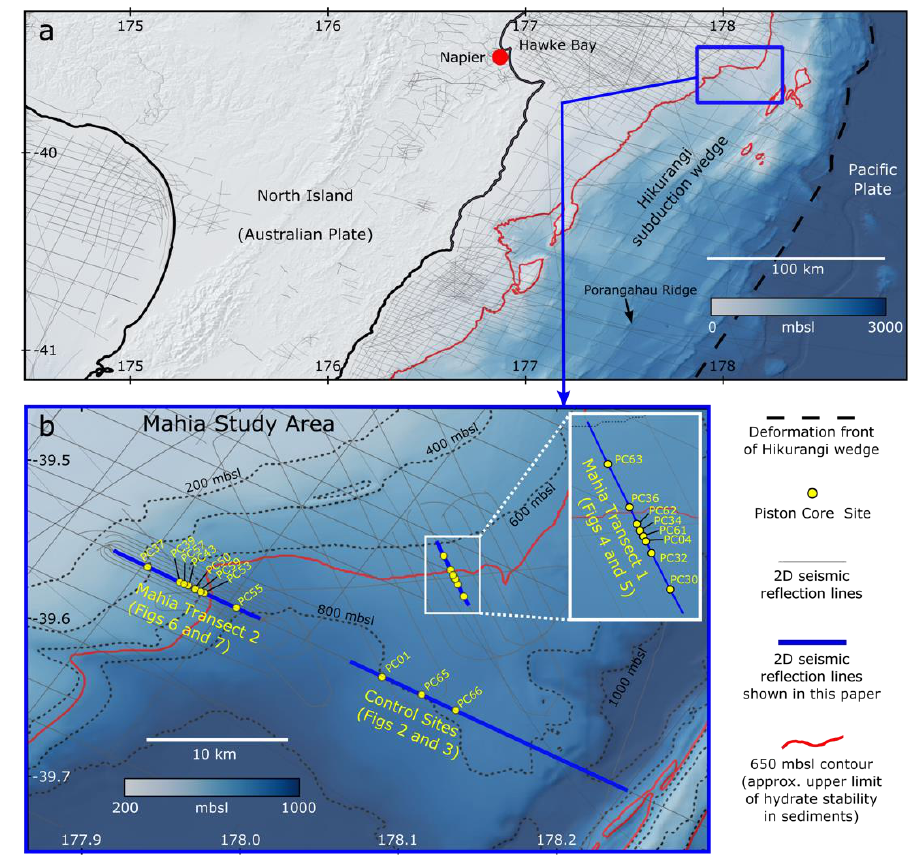
Figure 1. ( a ) Regional overview map showing the location of the study area (blue box) within the Hikurangi subduction wedge, east of New Zealand’s North Island. Map coordinates are in degrees (WGS84 datum). “mbsl” = meters below sea level. ( b ) Enlargement of the study area (Mahia Study Area) showing 2D seismic reflection lines shown in this study (blue lines), as well as piston core sites (yellow dots, labeled, e.g., PC01) at the three transects. The red contour marks the approximate upper limit of hydrate stability in sediments. Note: TOPAS data that we show in this manuscript are coincident with the seismic lines (blue lines).